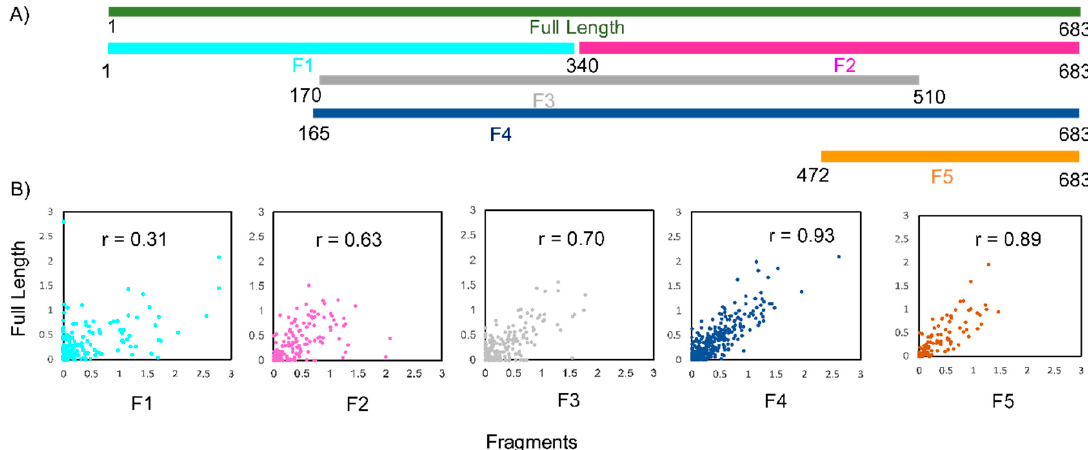
Figure 2. 3S (shotgun secondary structure) analysis of lncTCF7 fragments. ( A ) Schematic representing the position of lncTCF7 fragments corresponding to the full-length sequence. ( B ) Scatter plots comparing SHAPE reactivities of each fragment with the corresponding region in full-length lncTCF7. Pearson correlation coefficient ( r ) values are indicated.